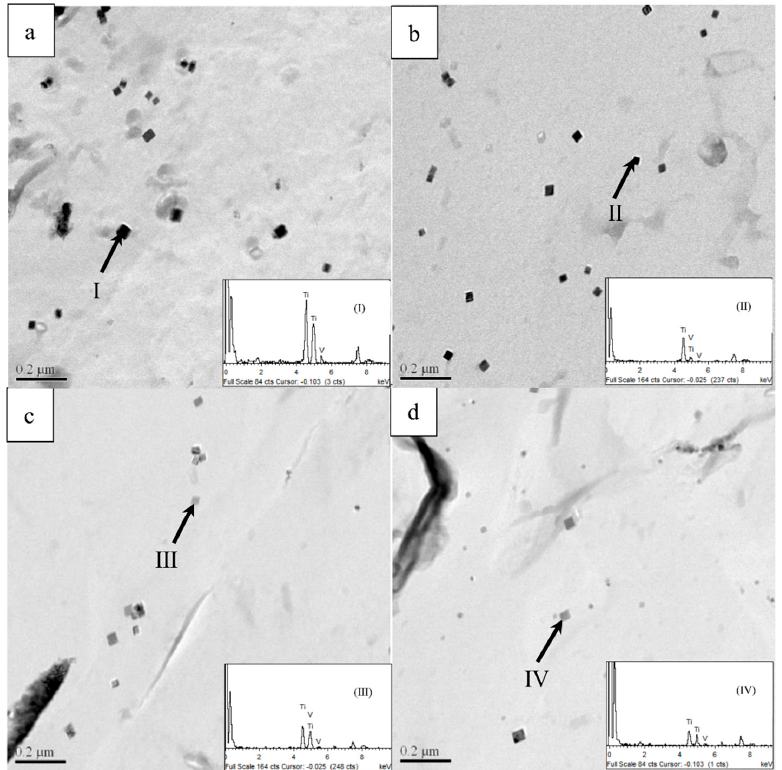
Figure 7. TEM observation of the precipitates in the simulated samples of ( a ) 120 kJ/cm, ( b ) 85 kJ/cm, ( c ) 65 kJ/cm, and ( d ) 35 kJ/cm and their EDS analysis results.